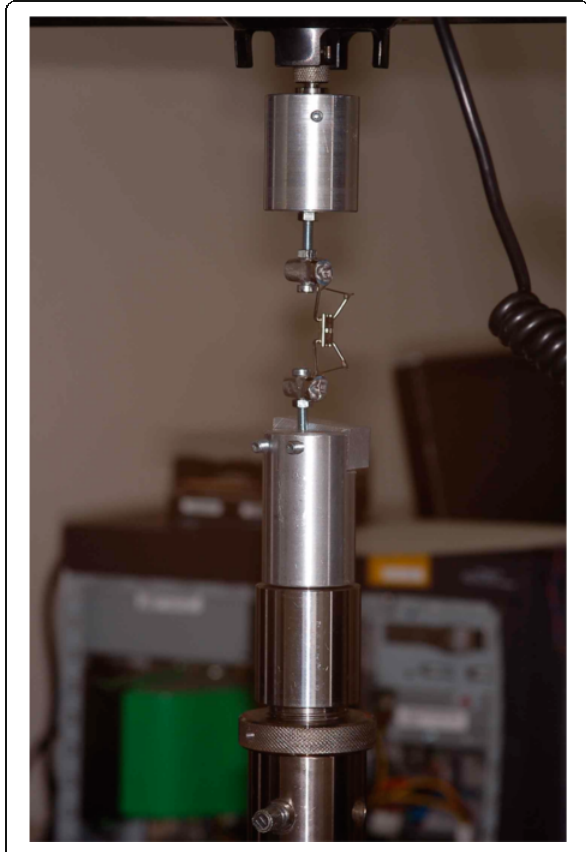
Fig. 4 Test RPE attached to the Instron machine aligned with the major axis of the